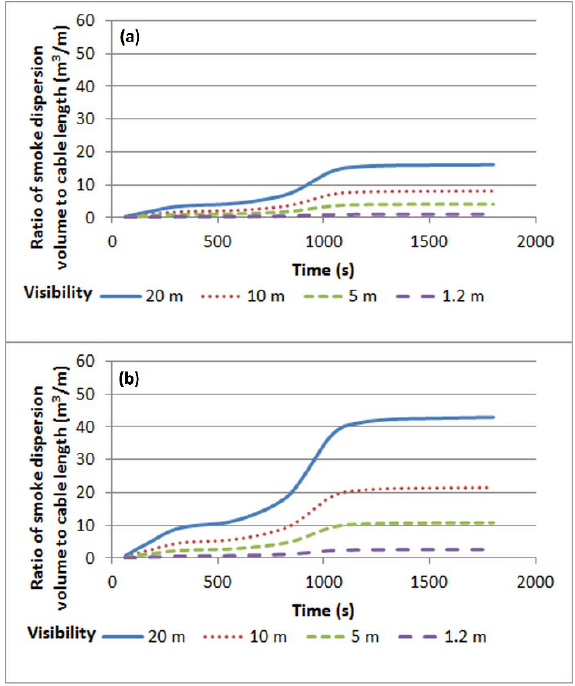
Figure 4. Critical ratios of smoke volume to length of the burning CHKE-V cable, by which the visibility of signs drop to 20, 10, 5 and 1.2 m for: ( a ) light-emitting signs; ( b ) light-reflective signs.